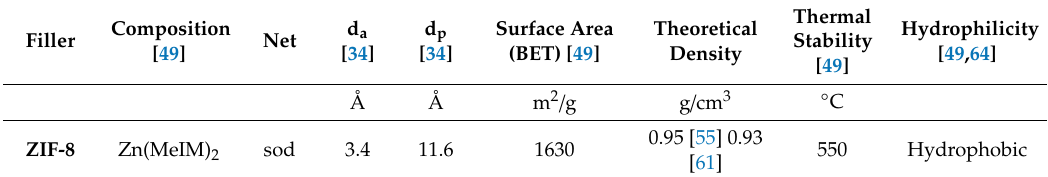
Table 2. Physical properties, composition, and reticular structure of